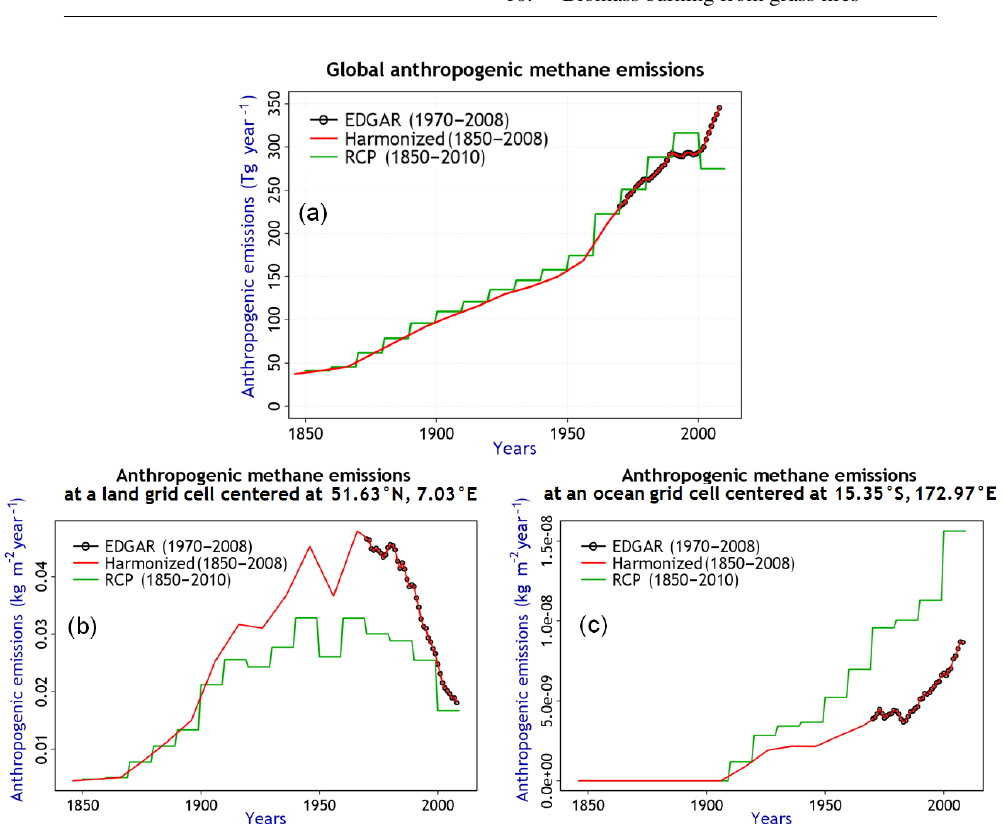
Figure 1. Comparison of RCP, EDGAR and their harmonized annual global anthropogenic methane emissions ( a ) excluding biomass burning. (b, c) illustrate the harmonization technique for a land and an ocean grid cell,